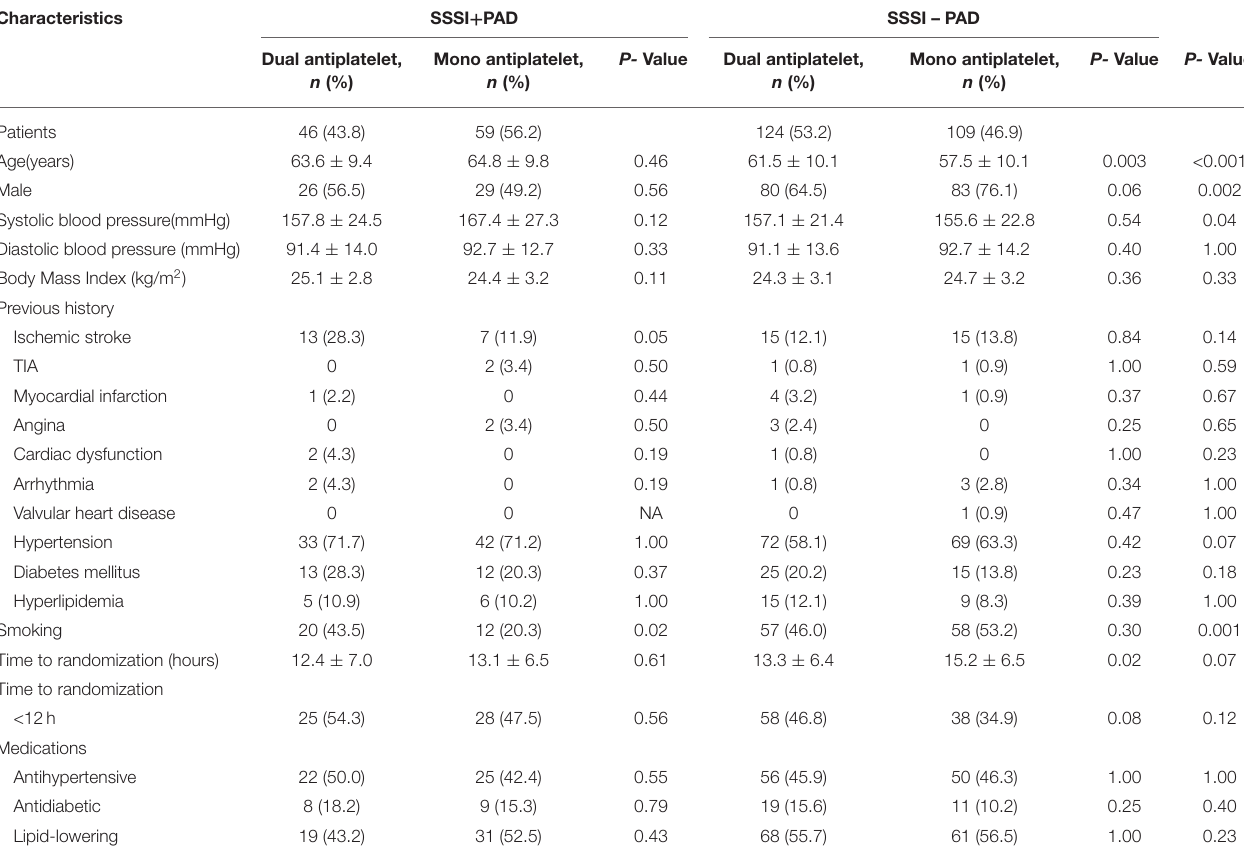
TABLE 1 | Baseline characteristics of the patients with SSSI + PAD and SSSI – PAD.